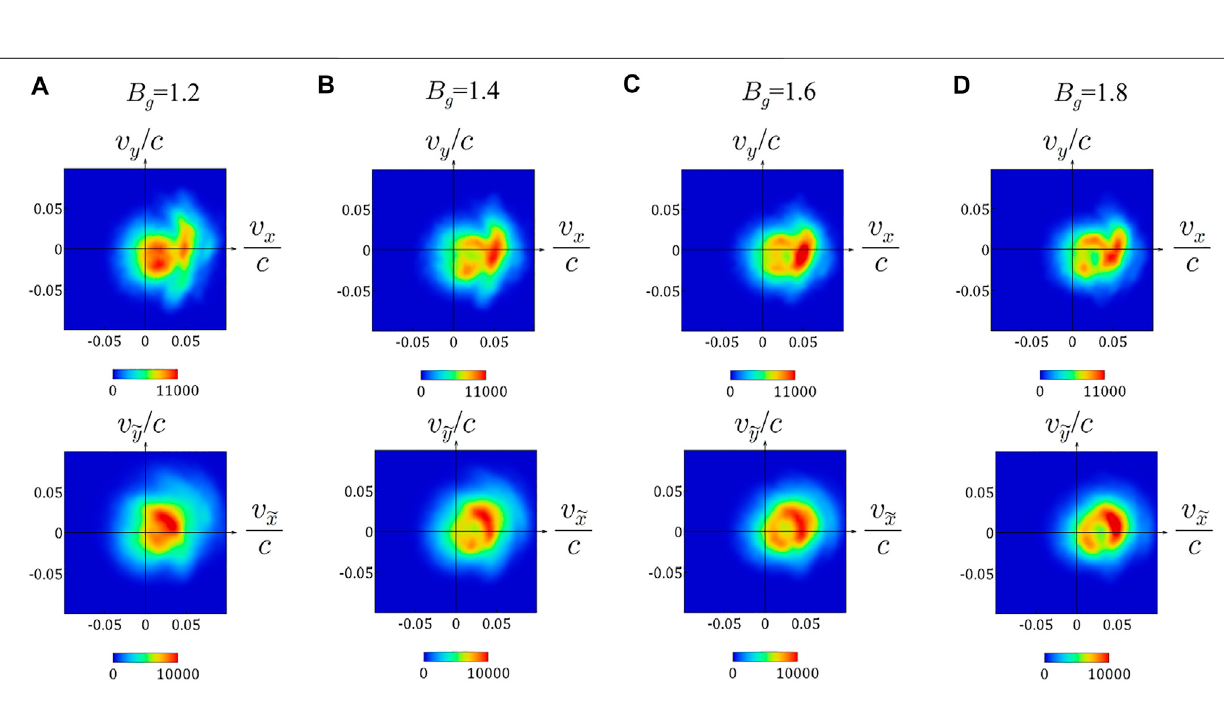
FIGURE 7 | Ion velocity distributions for various values of the guide fi eld ratio B g (A) : B g = 1.2 (B) : B g = 1.4 (C) : B g = 1.6, and (D) : B g = 1.8. The upper panels are taken in the ( v x , v y ) plane, and the lower panels are taken in the ( v ~ x , v ~ y )